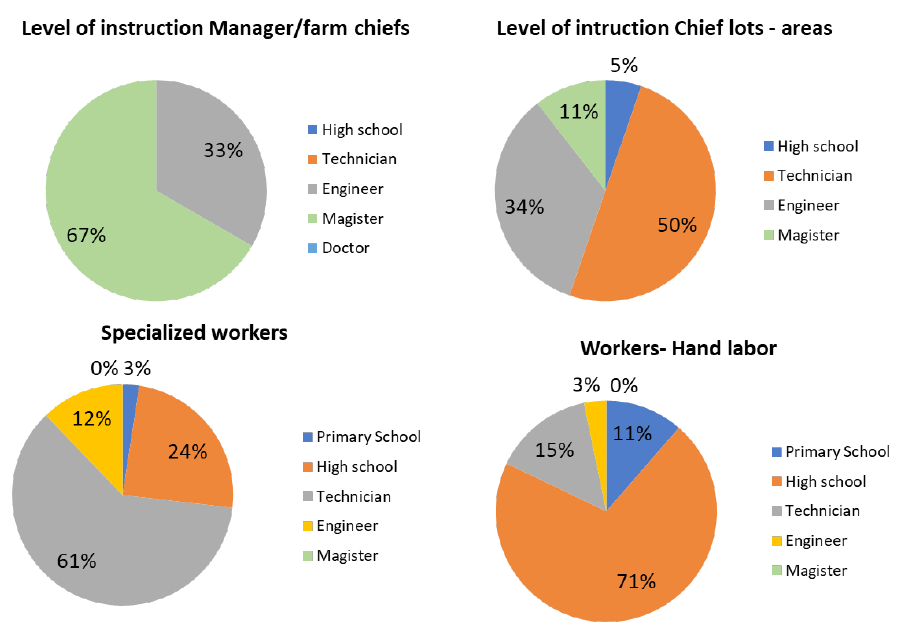
Figure 15. Level of education of the different types of workers of the asparagus and avocado fields of the Chavimochic irrigation project in 2017.